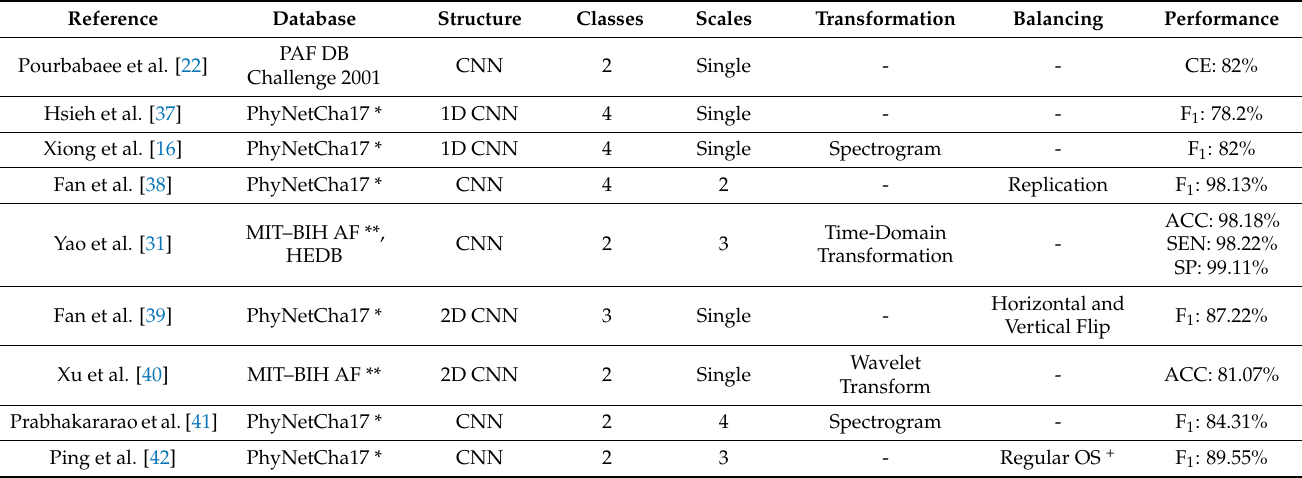
Table 1. State-of-the-art AF detection methods based on convolutional neural network (CNN) models with respect to the database, structure, classes, scales, transformation, balancing type, and